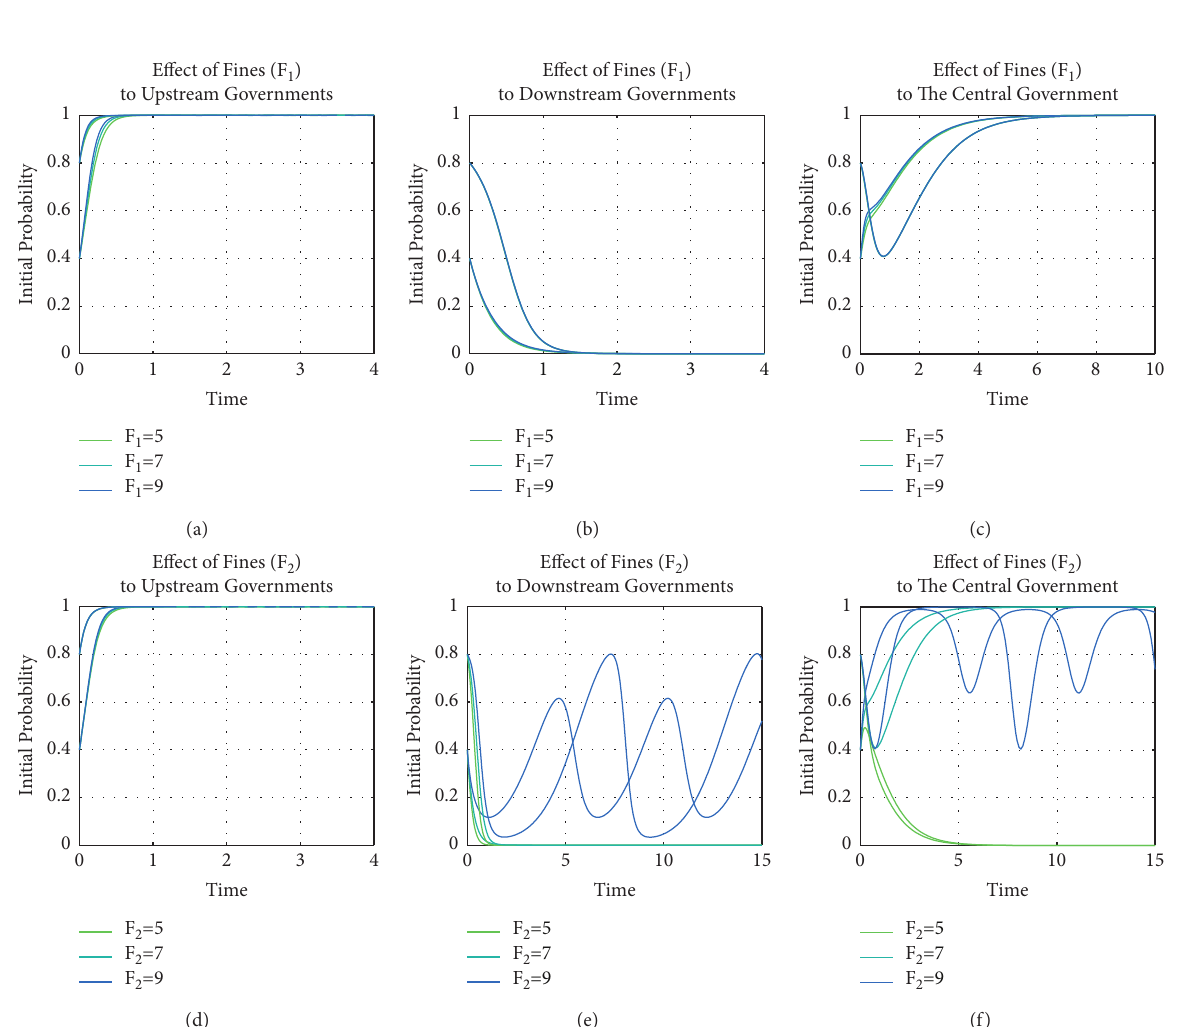
Table 7: The values of parameters in the simulation of fine ( F